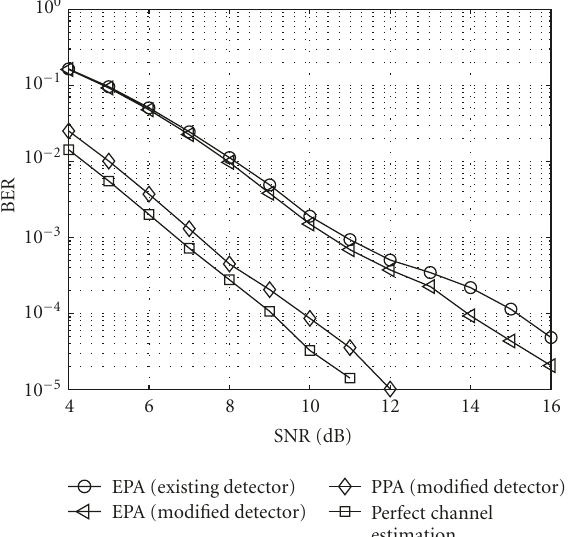
Figure 7: BER performance of di ff erent power allocation schemes (QPSK, M R = 4, M T = 3).